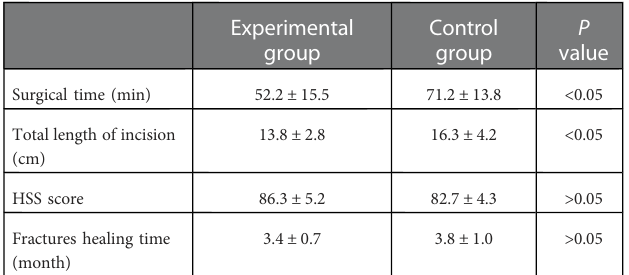
TABLE 2 Statistical